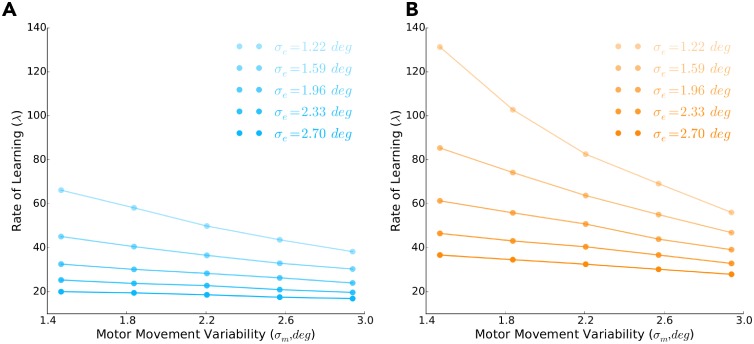
Predicting learning rates given motor and exploratory movement variability.In A) and B) we predict the rate of learning (λ; y-axis) after varying motor (σm, deg; x-axis) and exploratory (σe, deg; different shaded lines) contributions to movement variability, when the our learning model experiences the steep (blue) and shallow (orange) landscapes, respectively (n = 10, 000 per data point). In both A) and B) we find that increasing either σm or σe leads to a faster rate of learning (i.e., lower magnitudes of λ).